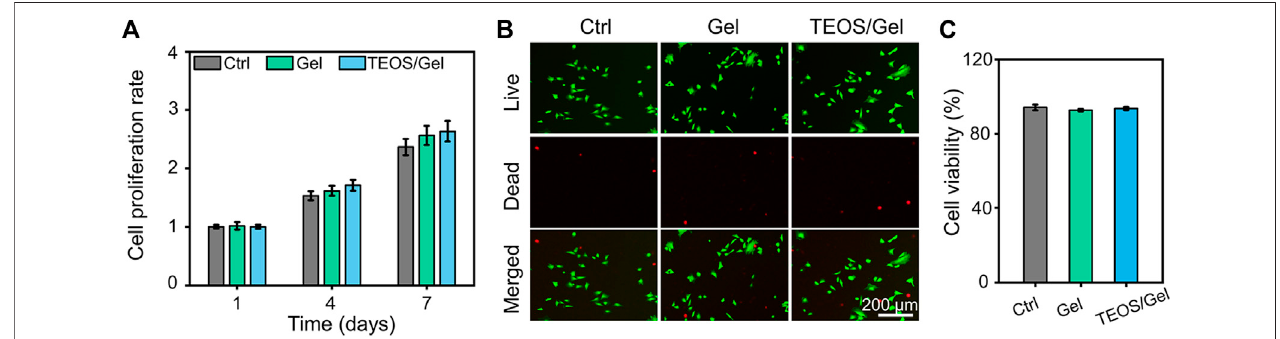
FIGURE2| Biocompatibilityofthepreparedhydrogels. (A) Cellproliferationrateatdays1,4,and7. (B) CalceinAM/PIstainingofBMSCsatday3. (C) Quantitative analysis of the cell survival rate by Calcein AM/PI